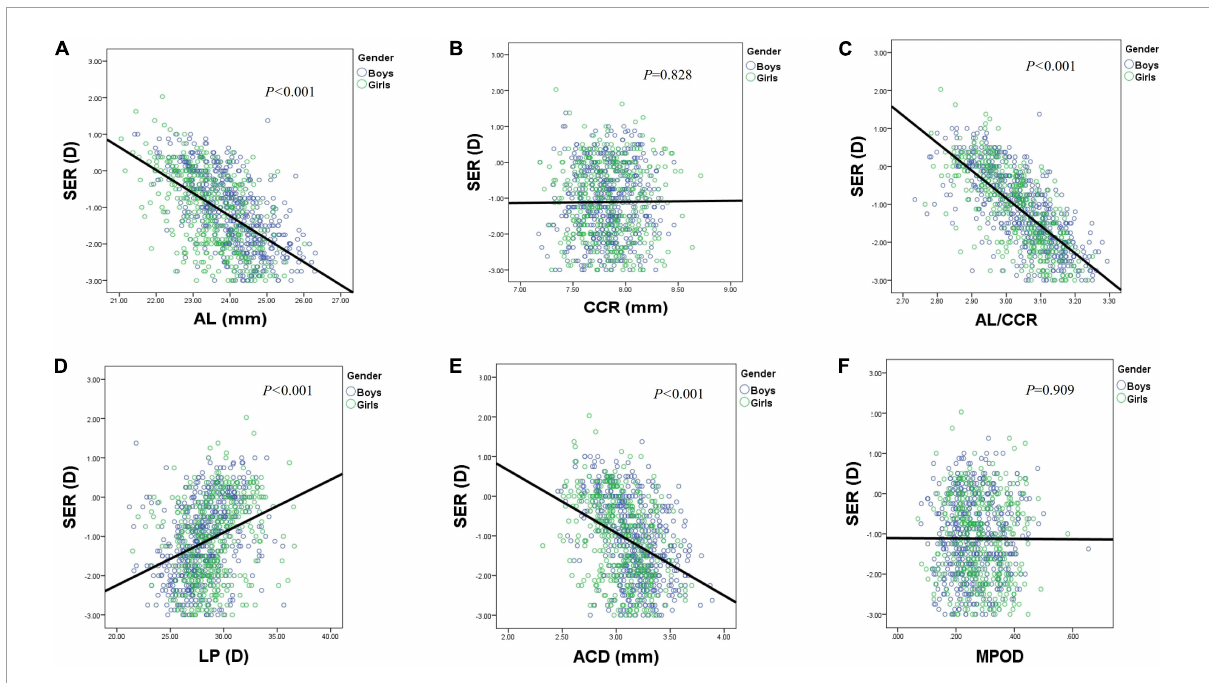
FIGURE5 Scatterplots showing individual data for SER by AL (A) , CCR (B) , AL/CCR (C) , LP (D) , ACD (E) , and MPOD (F) . AL, axial length; ACD, anterior chamber depth; CCR, corneal curvature radius; LP, lens power; MPOD, macular pigment optical density.